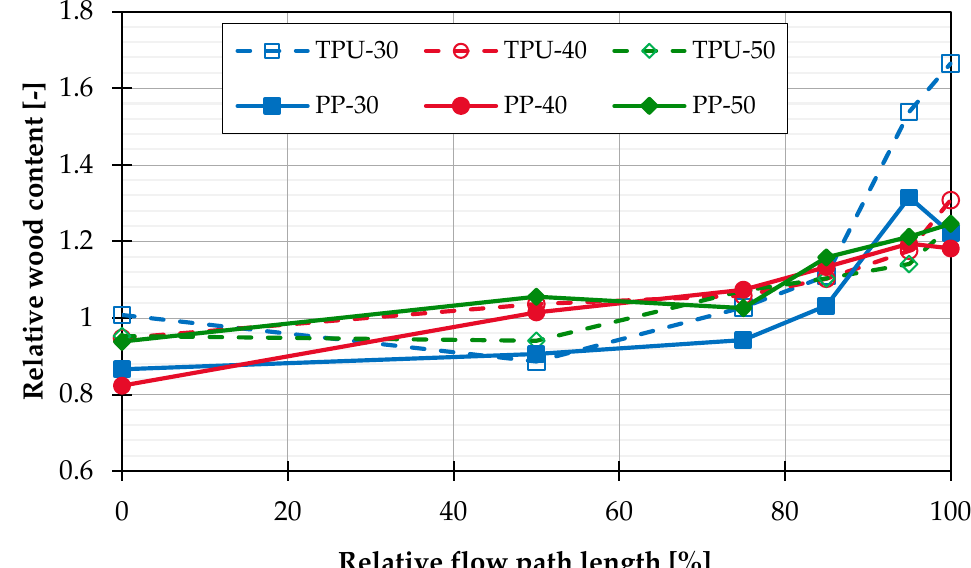
Figure 4. Absolute wood content over absolute flow path length as a function of matrix material (TPU, PP) and wood content (30, 40, 50 wt.%) at a melt temperature of 190 °C and a mold tempera- ture of 60 °C.